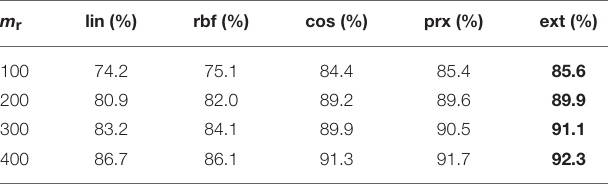
TABLE 1 | WebKB-4-University Document Classification. TABLE 2 | WebKB-4-University Document